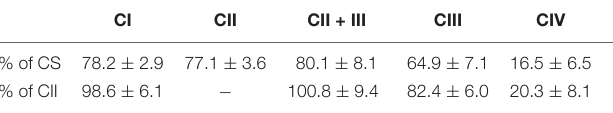
TABLE 1 | MRC enzyme assays of the muscle